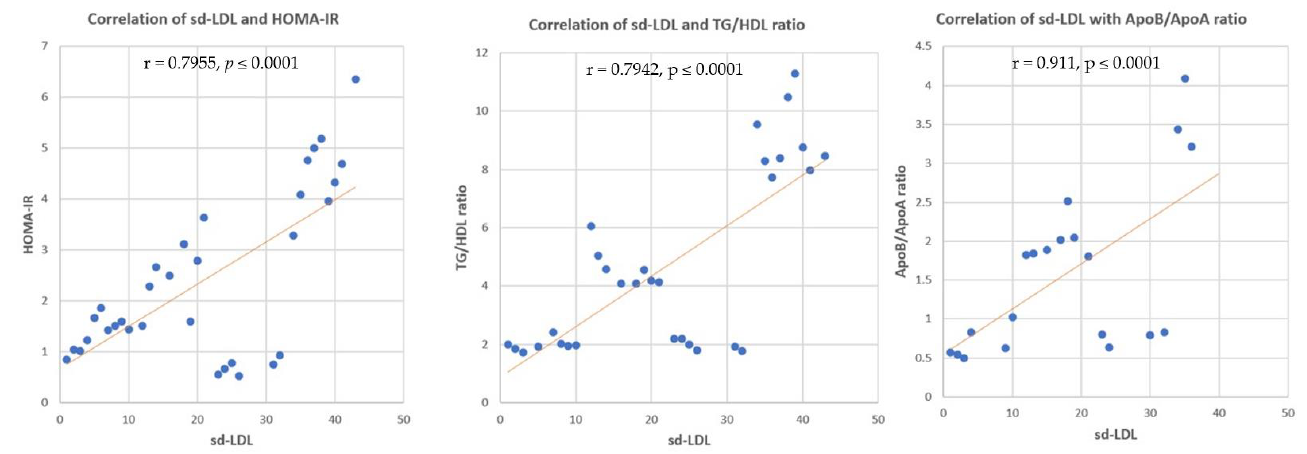
Figure 8. Correlation of sd-LDL and HOMA-IR, TG/HDL ratio, and Apo B/Apo A ratio. r = correla tion coefficient. p = value of statistical significance.